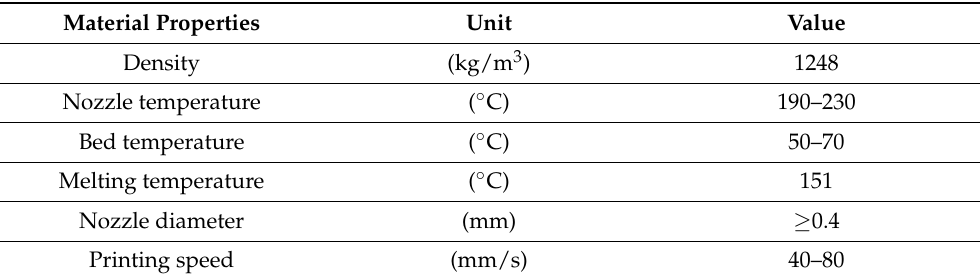
Table 1. Material properties and suggested printing parameters by the manufacturer.